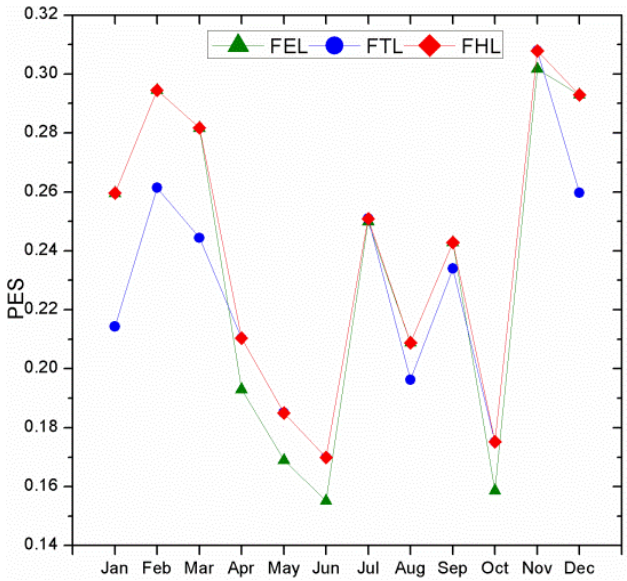
Figure 9. Variation of the primary energy saving based on simulated data for three basic CCHP operation strategies: FEL, FTL, and FHL.